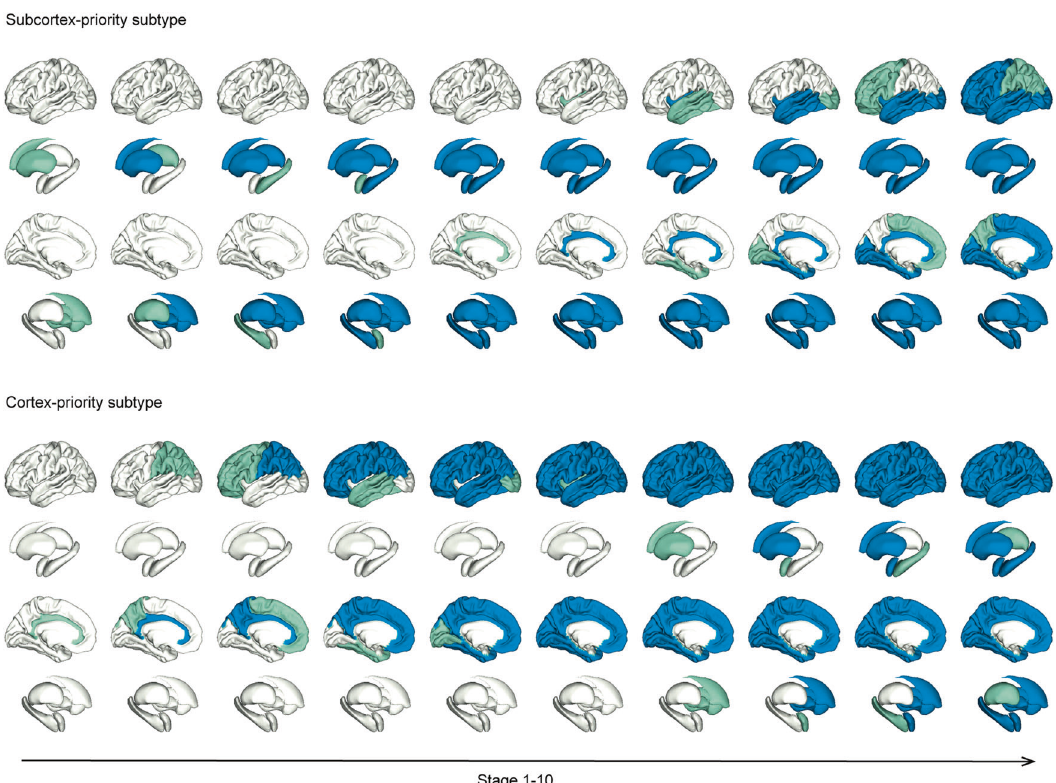
Fig. 1 Regional progression patterns of amyloid accumulation identi fi ed via the discovery dataset (ADNI2). Green shows the abnormal regions in the numbered stage and blue indicates abnormal regions from the previous stage. The last stage, cerebellum, is not shown here. In the subcortex-priority subtype, amyloid abnormality begins in several subcortex regions and successively affects the cingulate, amygdala, and insula, and fi nally the cortical regions. In the cortex-priority subtype, the cingulate is the fi rst abnormal region, followed by cortical areas, and then the insula and subcortical